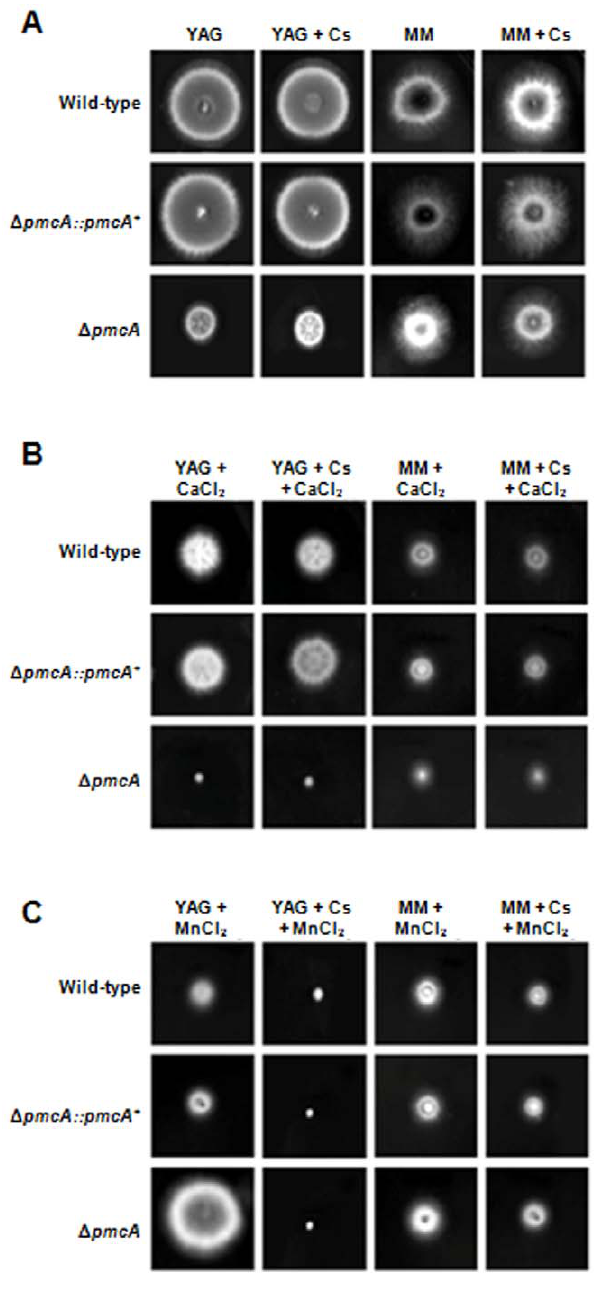
Figure 5. Growth phenotypes of the D pmcA mutant strain. The A. fumigatus wild-type, D pmcA::pmcA + and D pmcA mutant strains were grown for 72 hours at 37 u C in (A)YAG, YAG + 25 ng/ml cyclosporin (Cs), MM, or MM + 25 ng/ml Cs; (B) YAG + 500 mM CaCl 2 , YAG + 25 ng/ml Cs + 500 mM CaCl 2 , MM + 500 mM CaCl 2 , or MM + 25 ng/ml Cs + 500 mM CaCl 2 ; (C) YAG + 25 mM MnCl 2 , YAG + 25 ng/ml Cs + 25 mM MnCl 2 , MM + 25 mM MnCl 2 , or MM + 25 ng/ml Cs + 25 mM MnCl 2 .